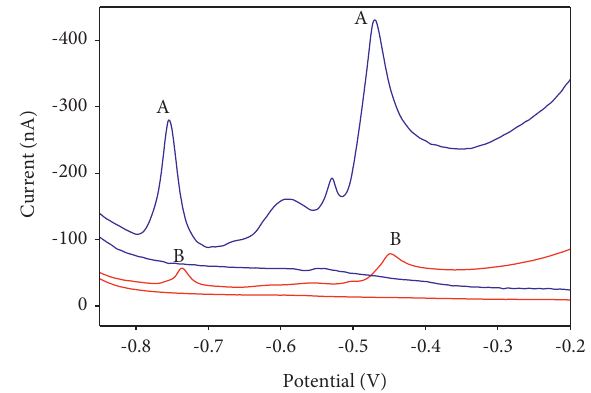
Figure 3: Linear sweep voltammetry of malathion in the presence of malathion in the presence of Cu 2+ ions at pH 2 at 800 (a) and 100 (b)mVs − 1 scan rate at pH 2 at the HMDE versus Ag/AgCl elec- trode. [Malathion] � 6.0 × 10 − 8 M and [Cu 2+ ] � 3.4 × 10 − 7